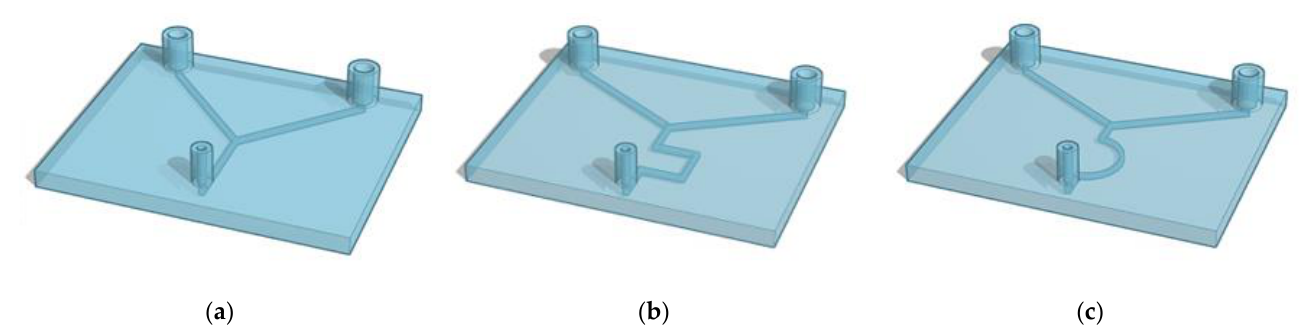
Figure 4. Representation of the 3D-printed microfluidic devices. ( a ) present 1 mm inlet channels that combine in one central channel that goes straight to the outlet point (Y shape). The same pattern of channels is designed both with a circular and squared ( a ) section. Devices ( b ) and ( c ) present 1 mm squared channels with zigzag- and half-moon-shaped channels, respectively.